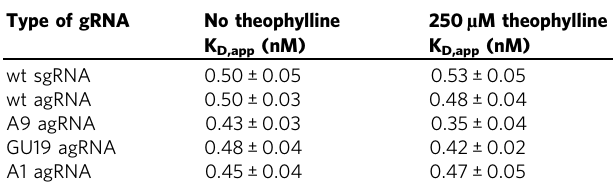
Table 1 Dissociation constants of Cas9 and different